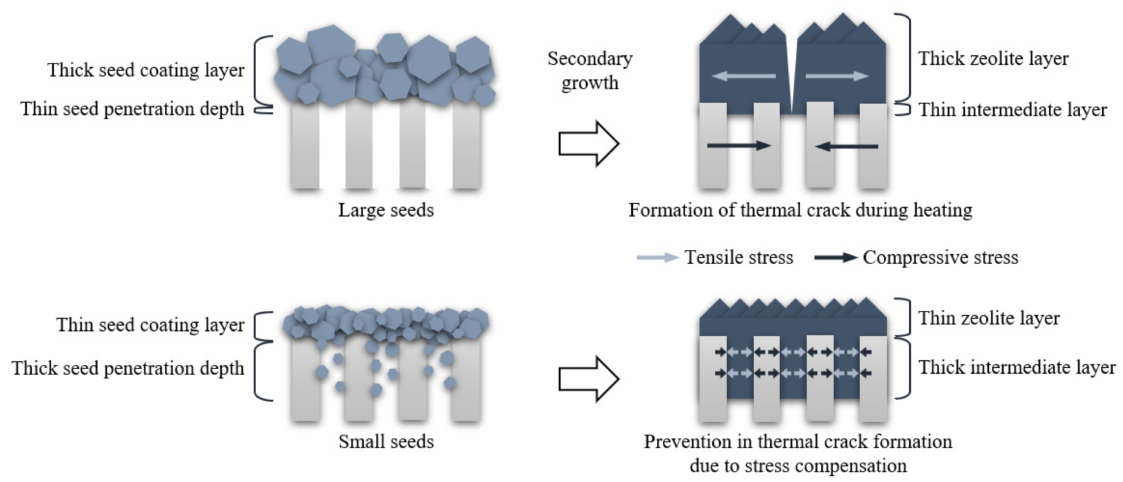
Figure 10. The schematic diagram for the formation of CHA zeolite membrane and prevention in thermal crack formation by controlling seed size.